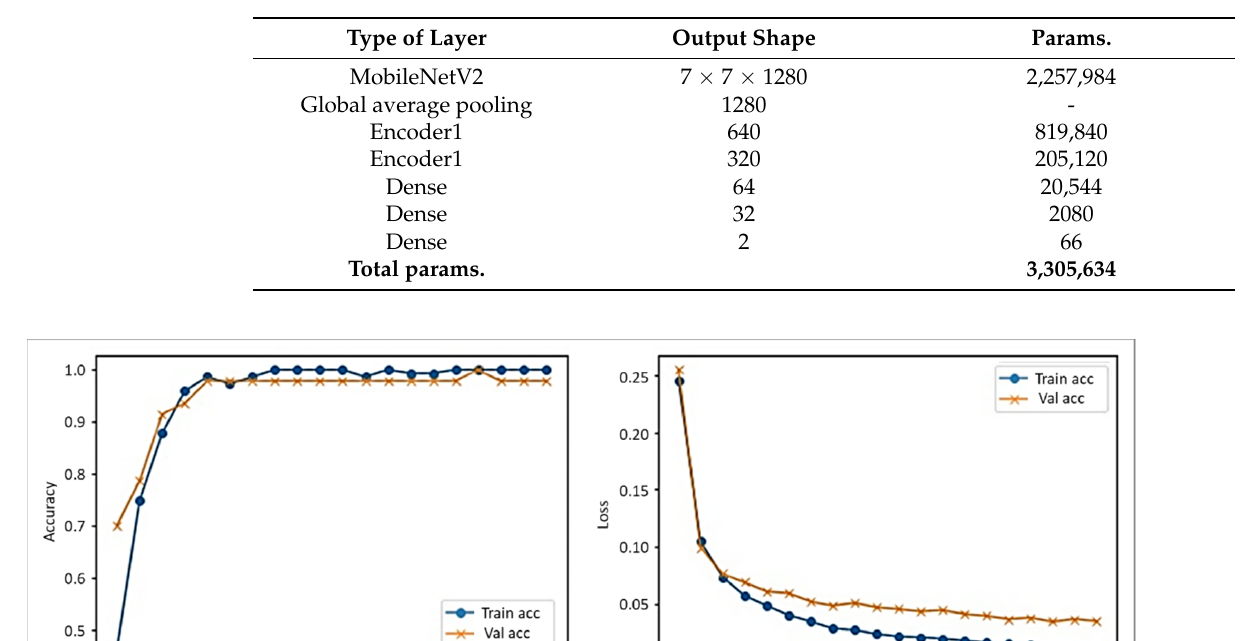
Table 3. The internal architecture of the proposed model.